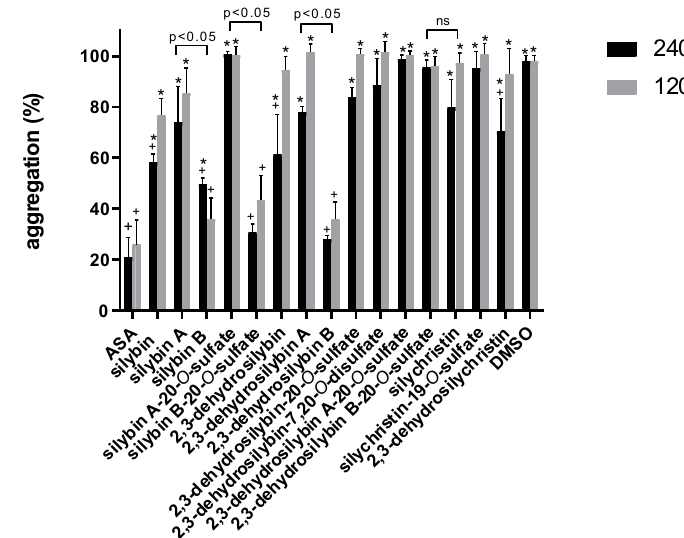
Figure 6. Effect of flavonolignans on whole-blood platelet aggregation induced by arachidonic acid. Data are expressed as mean ± SD. * p < 0.05 vs. acetylsalicylic acid (ASA); + p < 0.05 vs. solvent (DMSO); ns: p ≥ 0.05.